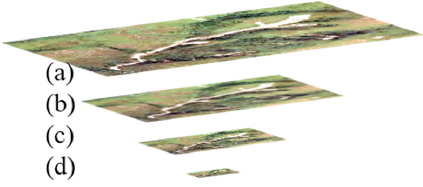
Figure 5. Multi-resolution images obtained using a Gaussian pyramid: ( a ) the original image of size 923 × 593, ( b ) the low-resolution image of size 461 × 296, ( c ) the low-resolution image of size 230 × 148, and ( d ) the low-resolution image of size 115 × 74.